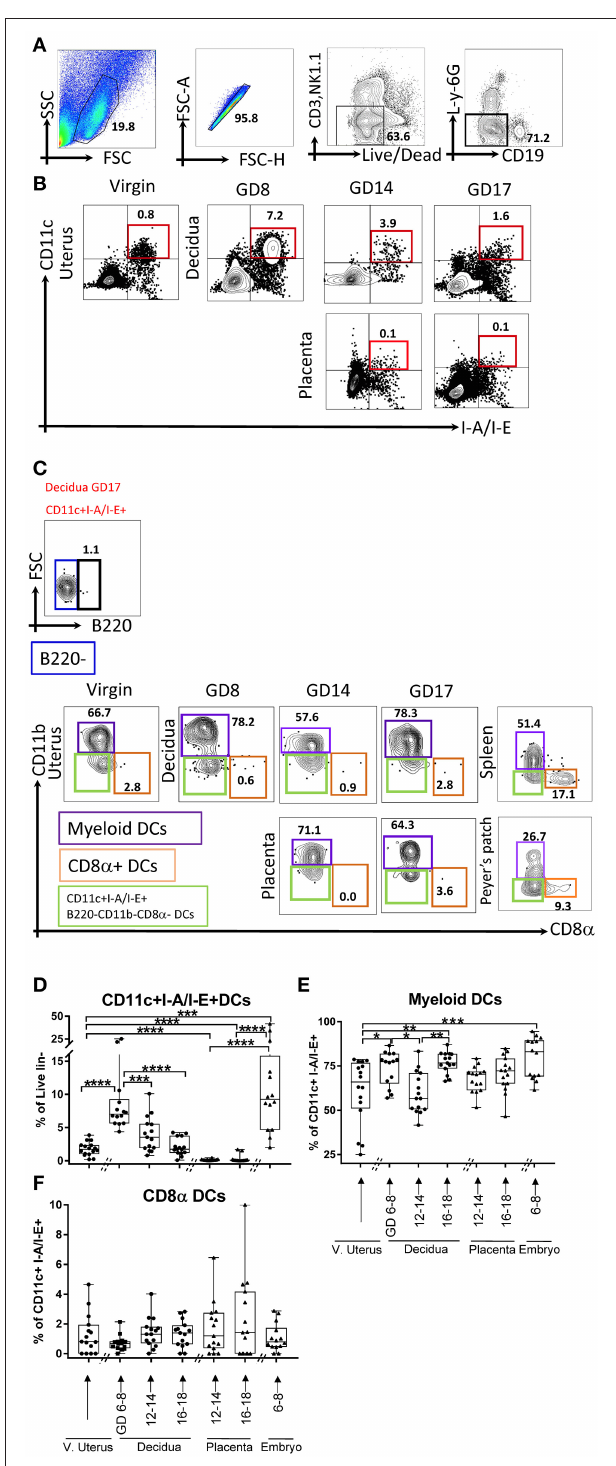
FIGURE 1 | Flow cytometry gating strategy showing dynamics of dendritic cells (DCs) in the murine uterus, decidua, placenta, and embryo. (A,B) Dendritic cells, defined as live and lineage negative (lin1-: CD3 neg NK1.1 neg CD19 neg L-Y-6G neg , A ) CD11c + I-A/I-E + (B) , were identified in the mouse virgin uterus, decidua ( B , top panel), and placenta ( B , lower panel) across